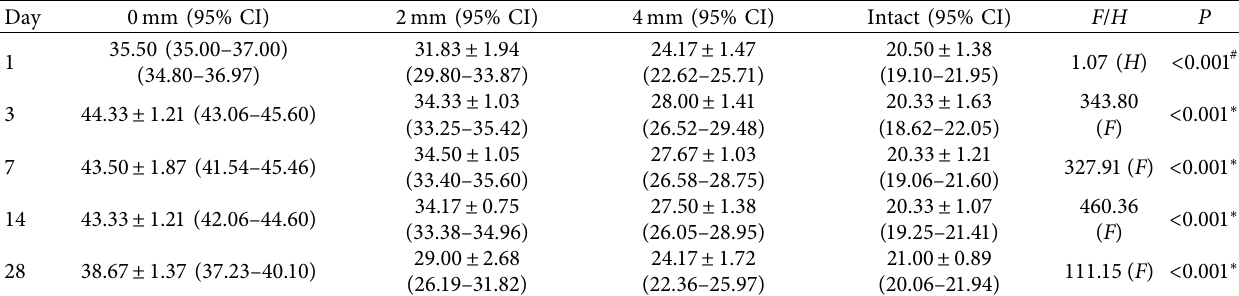
Table 4: Changes in mean number of microglia (/mm 2 ) in the C7 neurotomy subgroups.